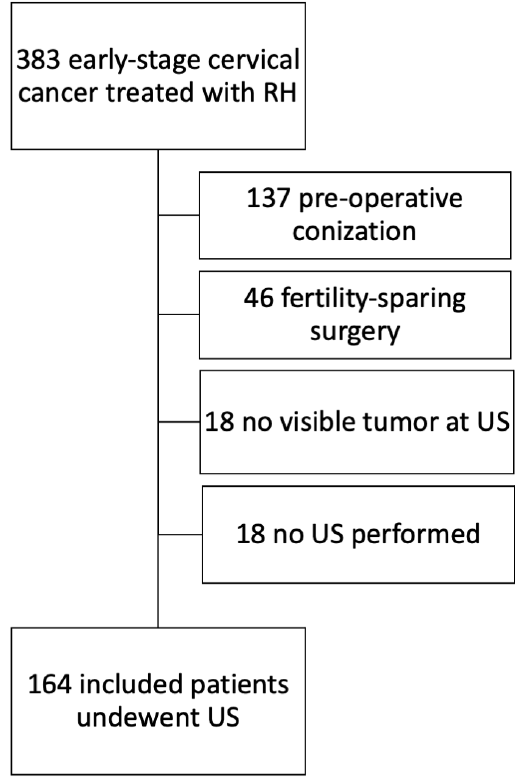
Figure 2. Flow chart demonstrating the exclusion process.